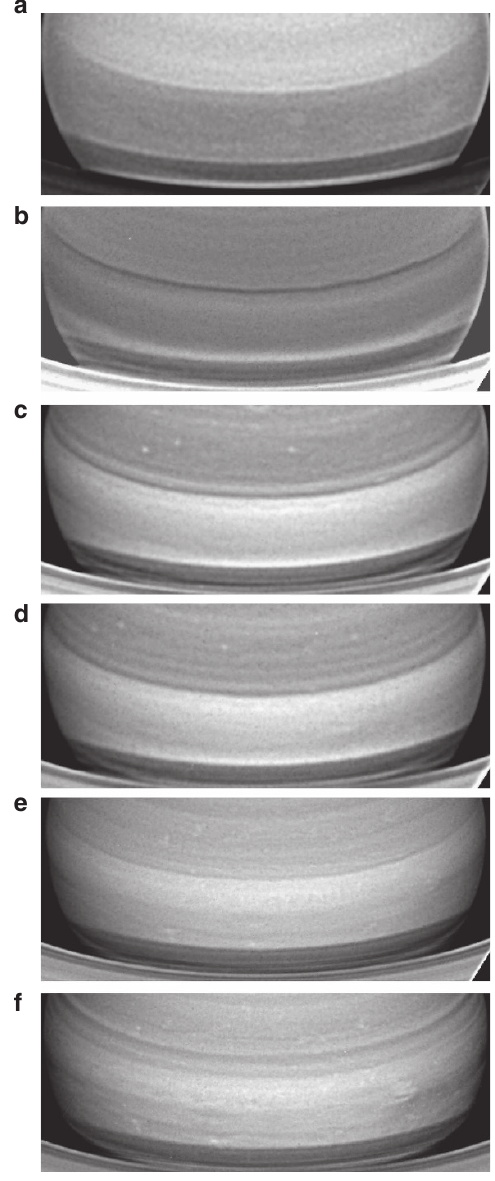
Figure 5 | Multi-wavelength aspect of Saturn’s Equatorial Zone. HST-WFC3 images obtained on 29 June at the following wavelengths: ( a ) 225nm; ( b ) 420nm; ( c ) 502nm; ( d ) 547nm; ( e ) 689nm; ( f ) 937nm. Image details are in Supplementary Table 2.